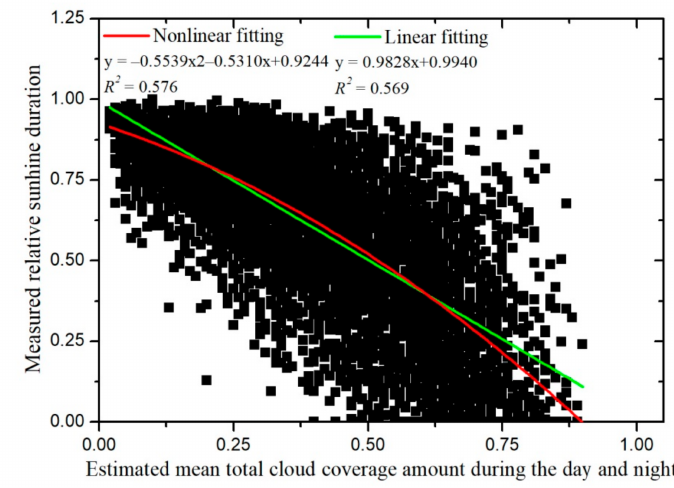
Figure 8. Relationship between average total cloud coverage amount during the day and night and measured relative sunshine duration for 18 meteorological stations from 1 January 2017 to 31 December